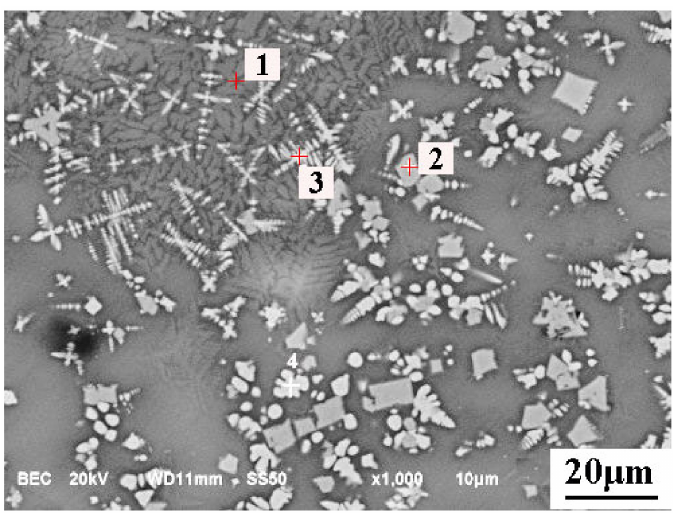
Figure 11. SEM micrograph (backscattered electron) of the dephosphorization slag in Heat